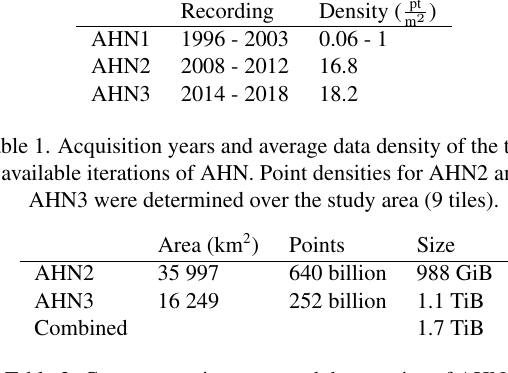
Table 2. Coverage, point count and dataset size of AHN2, AHN3 and a combination of